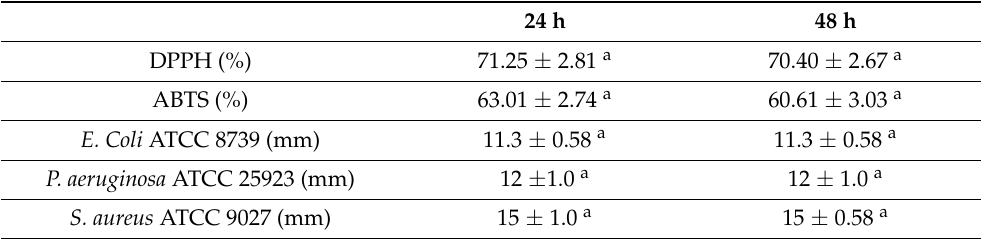
Table 1. Antioxidant and antibacterial effects of SeNPs produced by